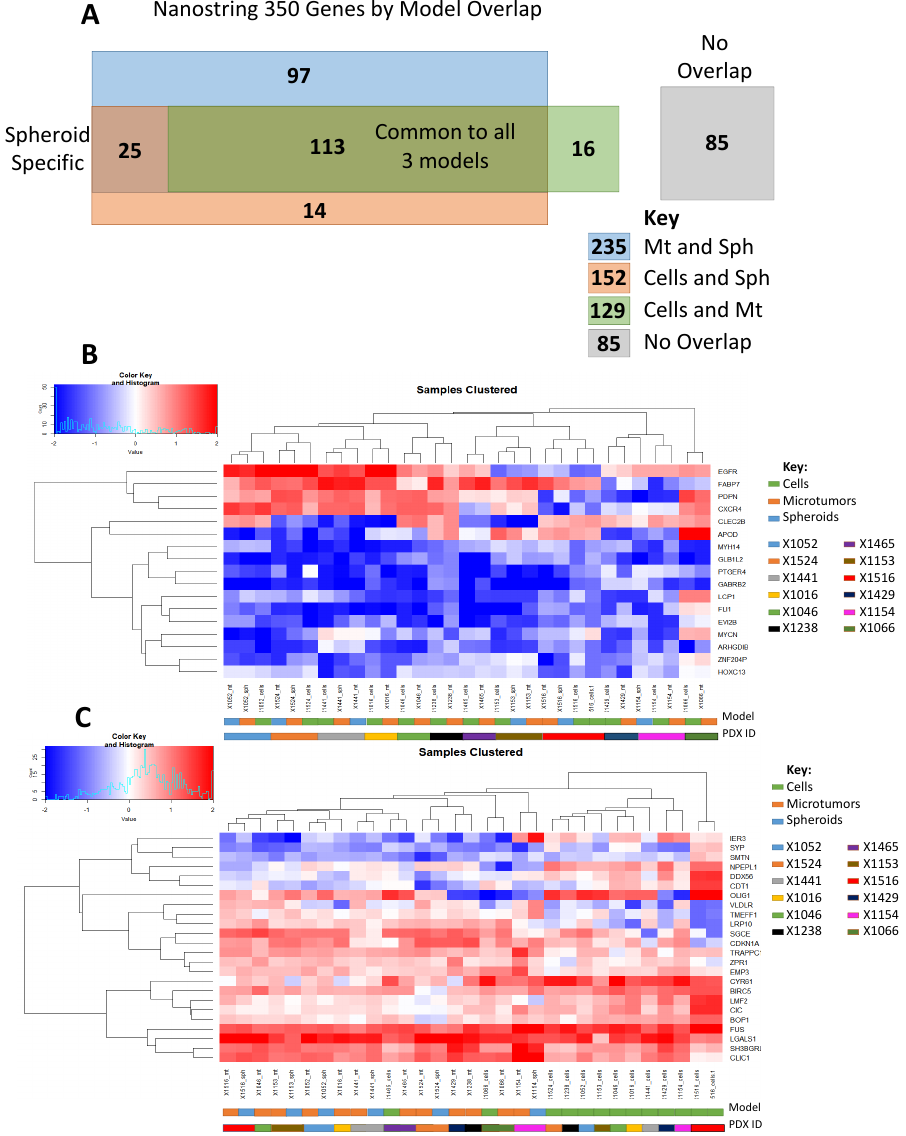
Figure 3. Model specific and independent e ff ects: ( A ) Overlap of 350 NanoString genes between three di ff erent patient-derived models; ( B ) Heatmap of 17 genes derived from the core set of 113 genes which cluster samples by tumor of origin; and ( C ) Set of 24 genes found to be associated with tumor model (Kruskal–Wallis p ≤ 0.01) which cluster samples based on tumor